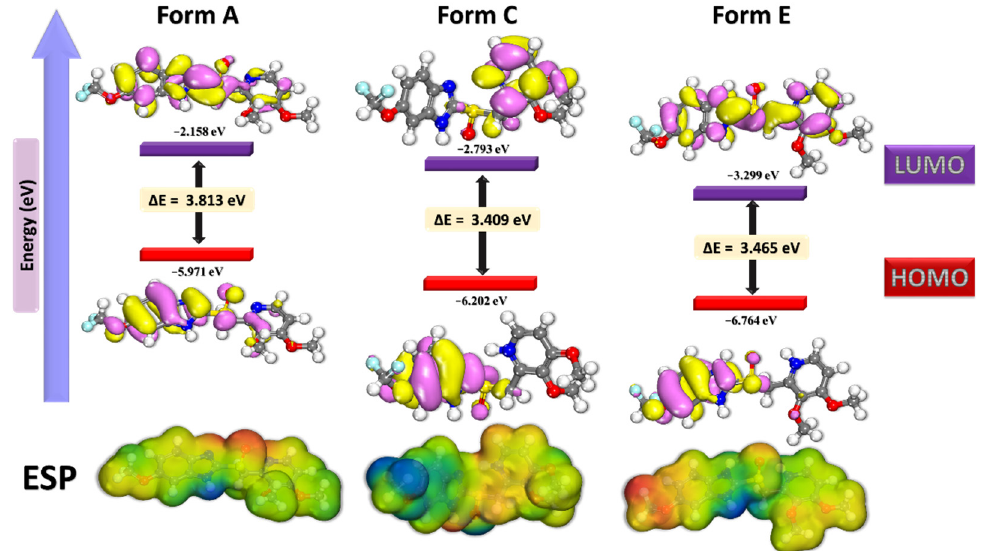
Figure 4. HOMO and LUMO surfaces as well as the electrostatic potential (ESP) for different protonated forms of a Pantoprazole molecule.